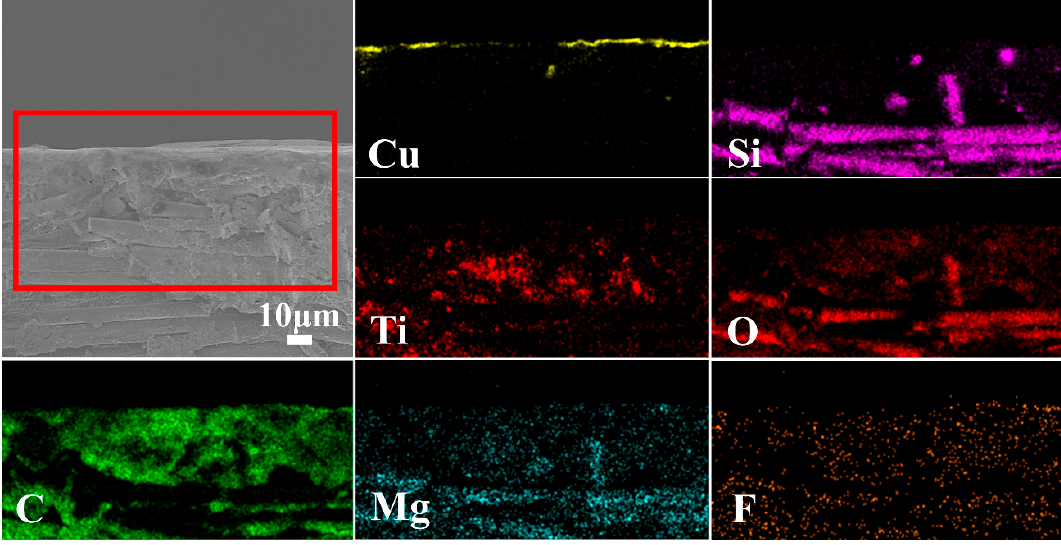
Figure 7. Corresponding element mapping of Cu, Si, Ti, O, C, Mg, F of LT-CCLs.